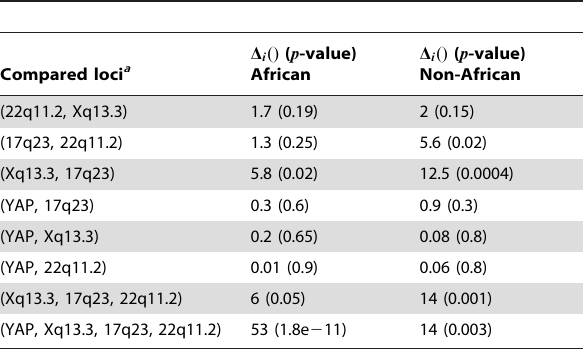
Table 4. The values of minus twice of log of likelihood-ratio statistics for Test III.